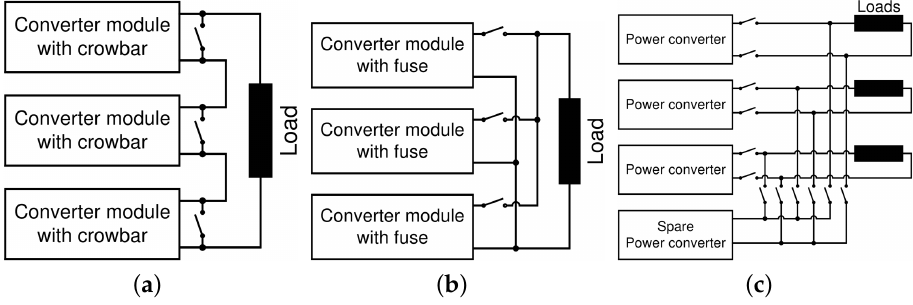
Figure 1. Redundant structure of the power supply. ( a ) Series redundancy diagram. ( b ) Parallel redundancy diagram. ( c ) Hot spare